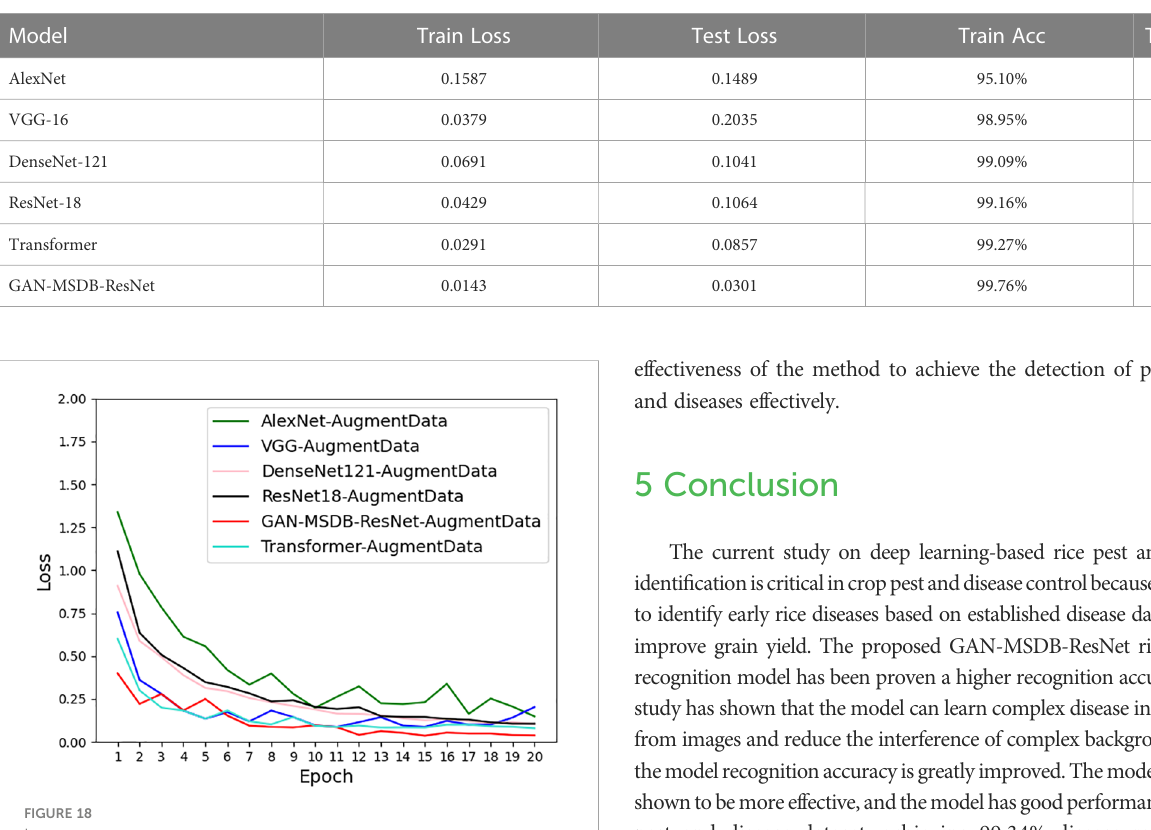
TABLE 5 Accuracy and Loss of different networks.